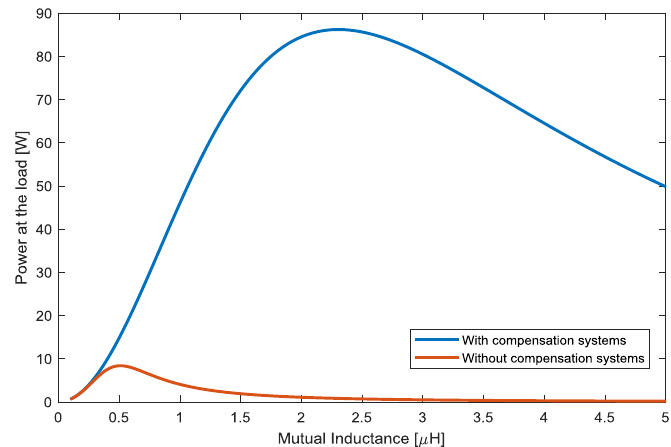
Figure 3. Power delivered to the load in a SCMR system with and without compensation systems in the driver and the load circuits.